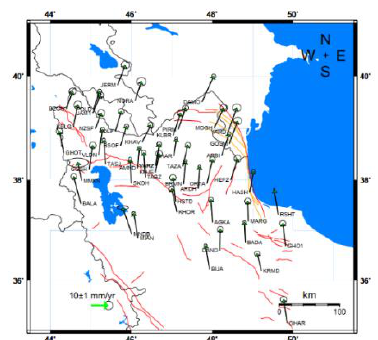
Figure 2. Map of the GPS velocity vectors (with respect to Eurasia- fixed frame (EURA_I08)) and their corresponding 95% confidence level